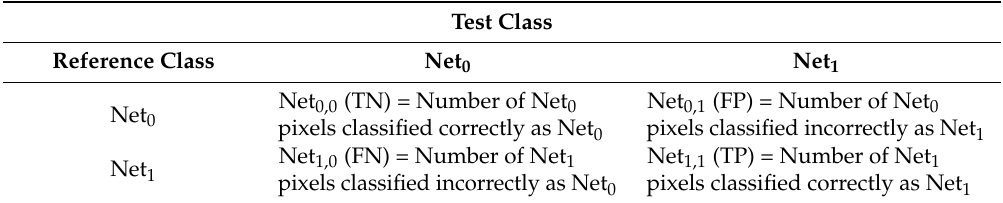
Table 2. Outcomes of classification matrix resulting from comparing a LiDAR DTM/DSM-derived channel network (reference class) and a global DEM-based network (test class); where Net denotes network.